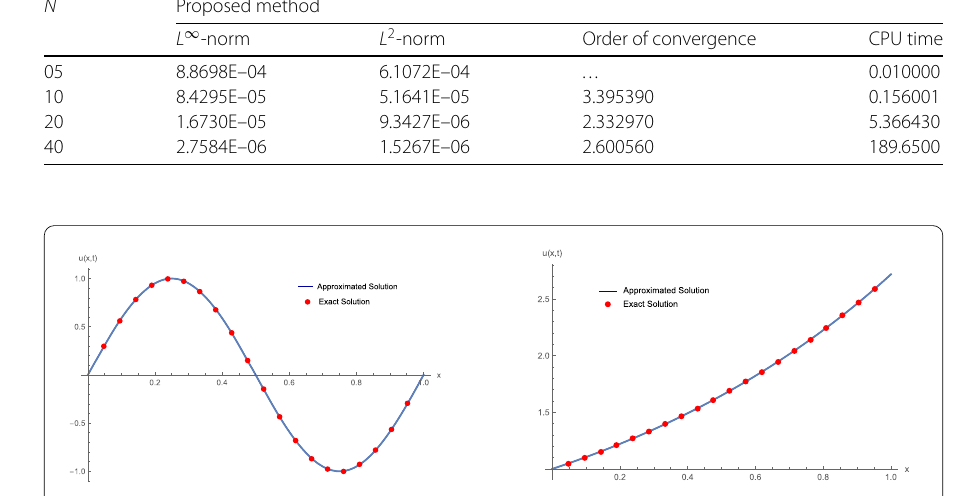
Figure 1 Comparison plots of exact solutions and approximated solutions for Problem 1 and Problem 2,